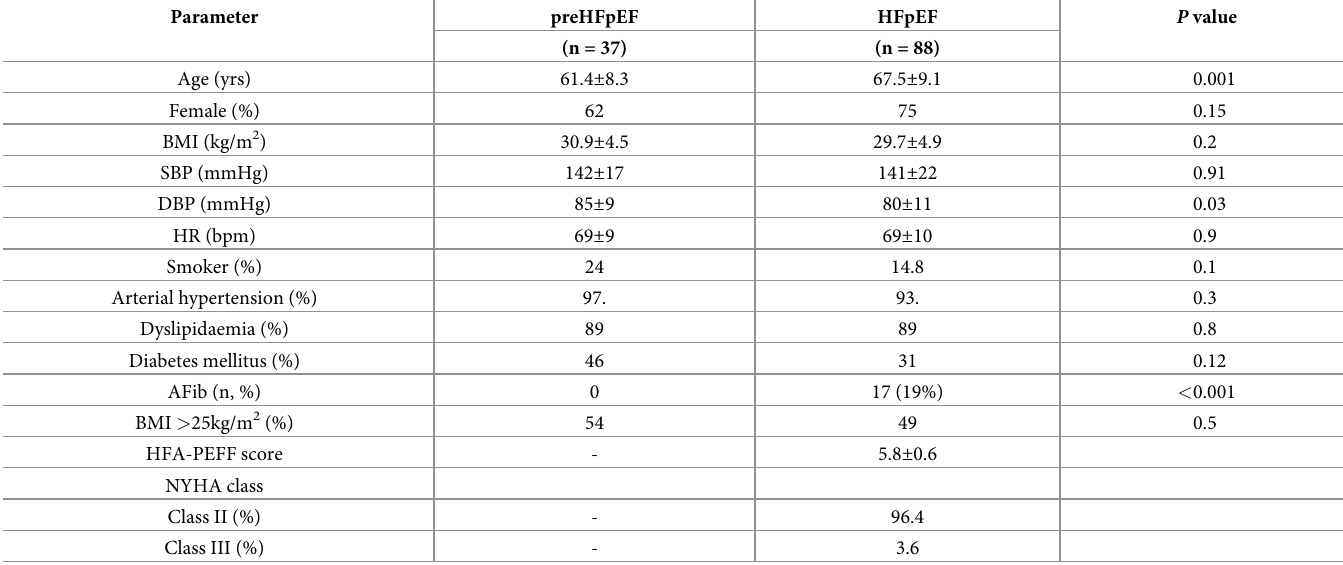
Table 1. Demographic and clinical characteristics of all